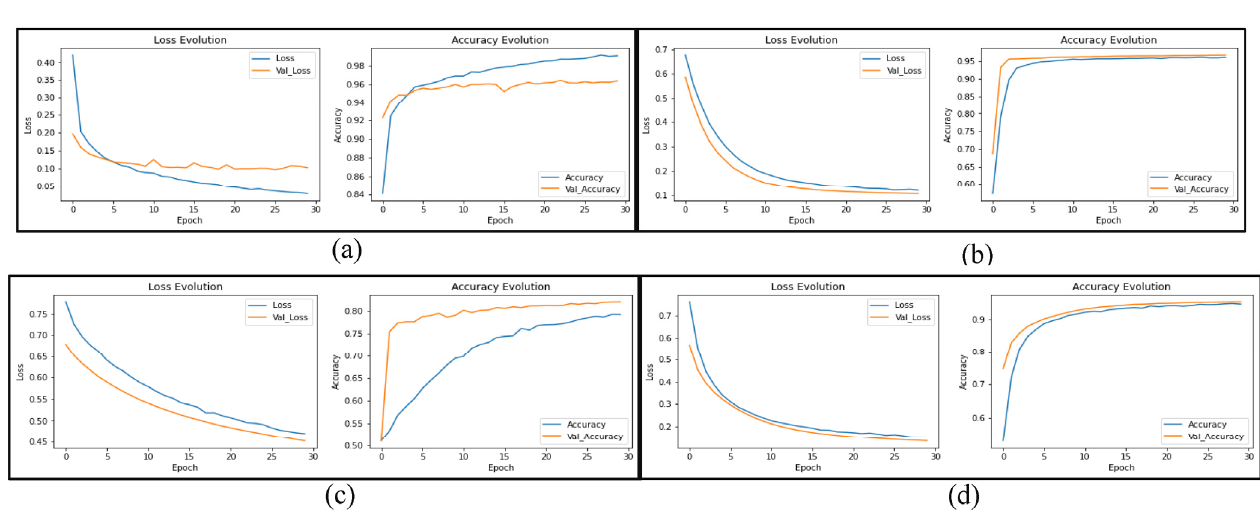
Figure 14. Learning curves of the models: ( a ) VGG16; ( b ) Xception; ( c ) ResNet50; ( d ) MobileNetV2 to transfer learning from Scenario2 for skin cancer classification with data augmentation.